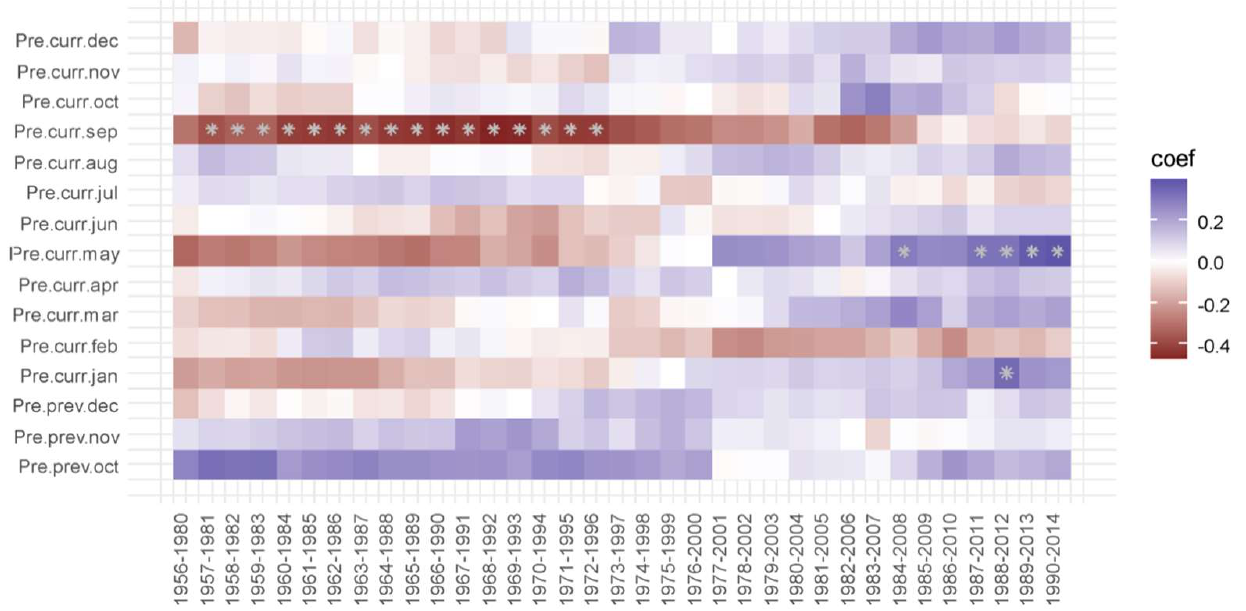
Figure 4. Moving correlation coefficients between tree-ring chronology and precipitation; prev. and curr. indicate previous and current years; * indicates significance at 0.05 level.